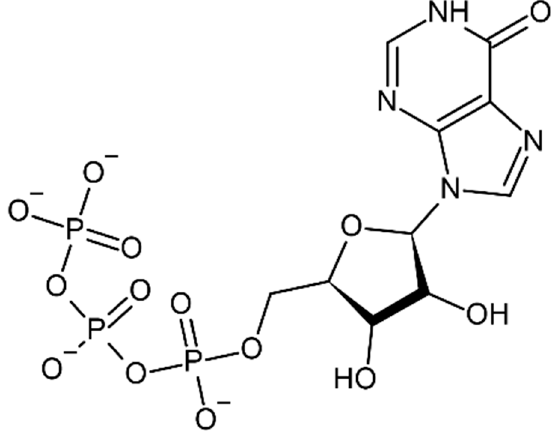
Figure 1. Chemical structure of Inosine triphosphate (ITP).